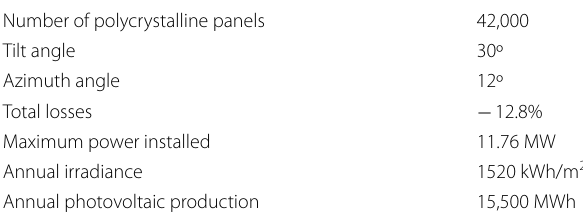
Fig. 9 Annual wind energy production on Terceira island